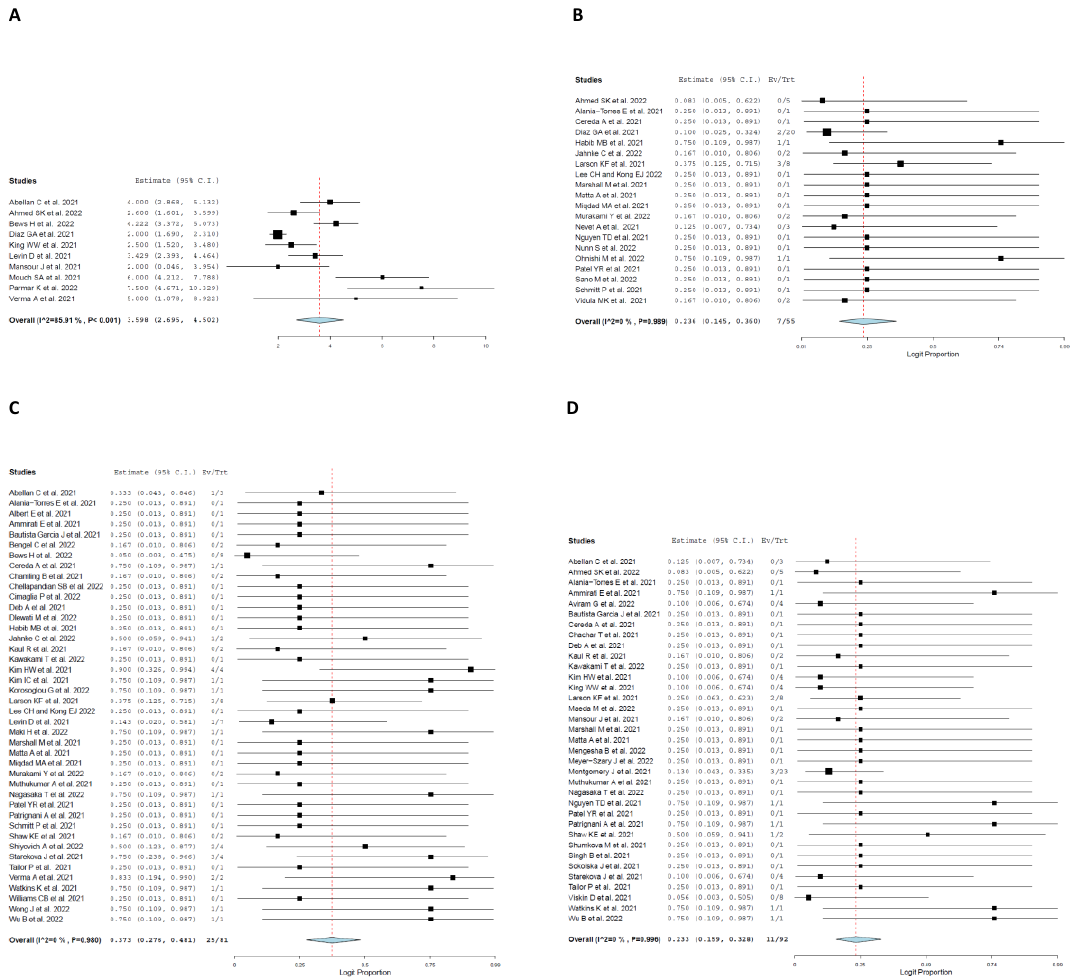
Figure 5. Forest plot of clinical course and other pertinent clinical findings. ( A ) Length of hospital stay. ( B ) Intensive care unit admission. ( C ) Pericardial effusion. ( D ) Prior COVID infection.